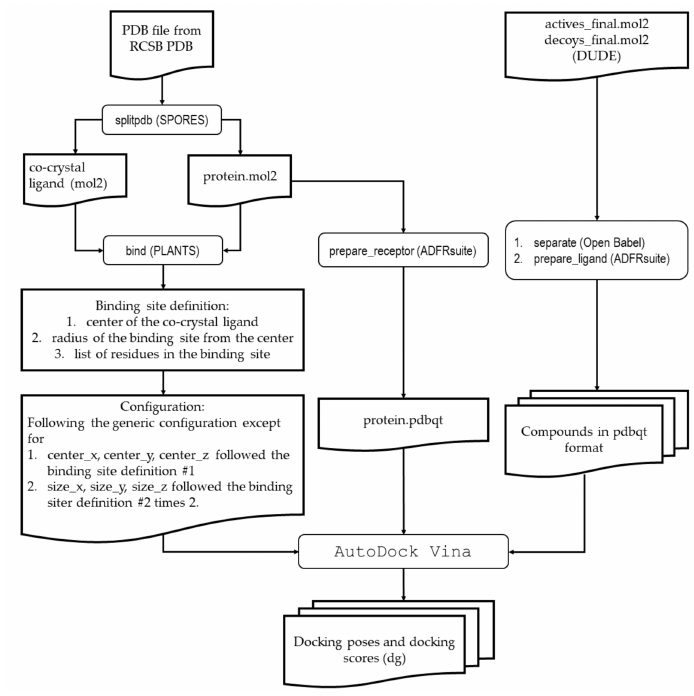
Figure 5. The procedure of the retrospective SBVS